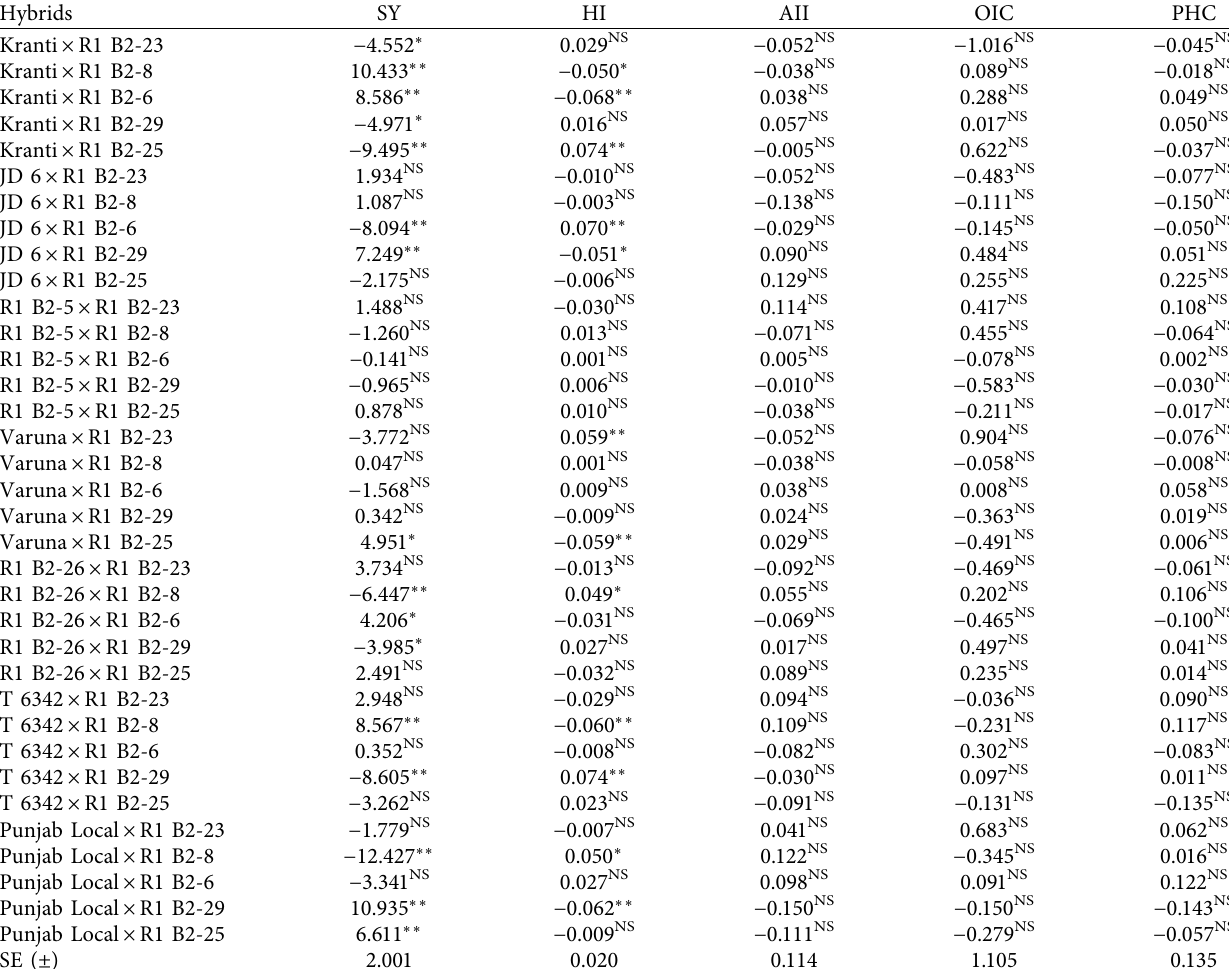
Table 11: Specific combining ability (SCA) effects of mustard hybrids on yield and its attributed